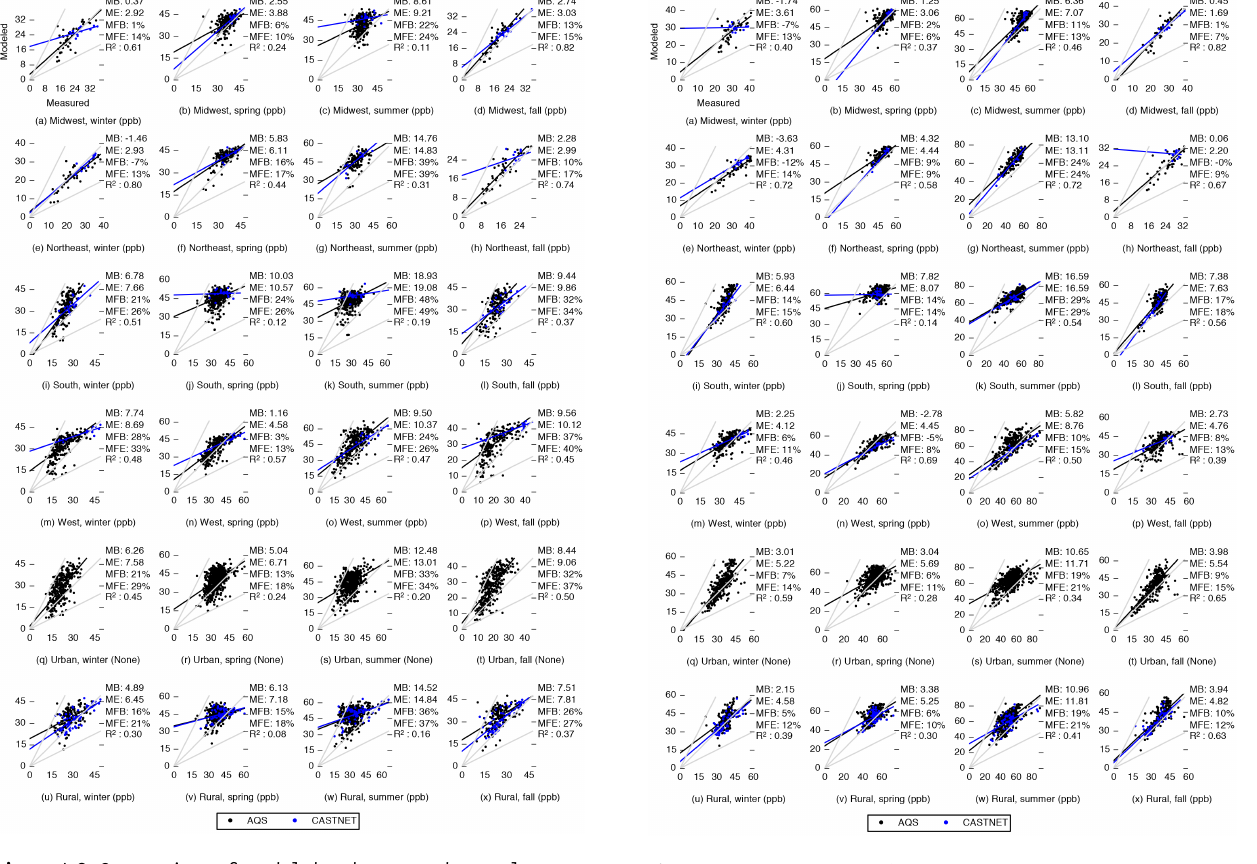
Figure A7. Comparison of modeled and measured average daily peak O 3 concentrations, disaggregated by region and